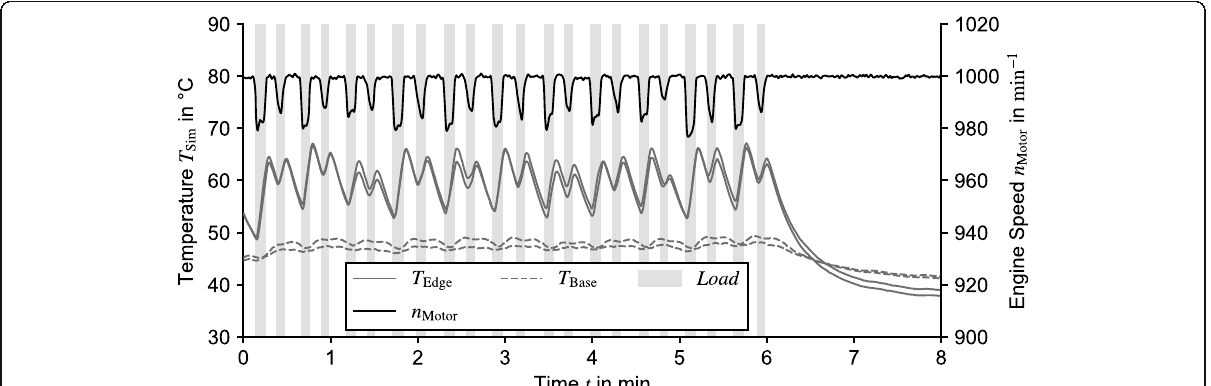
Fig. 6 Temperature and motor speed measurement for Wet Blue during shaving. Grey lines represent temperatures T Edge close to the edge of the knife and T Base close to the roller base. The black line plots the engine speed n Motor . The grey shaded bars indicate that the machine is under load due to loss in engine